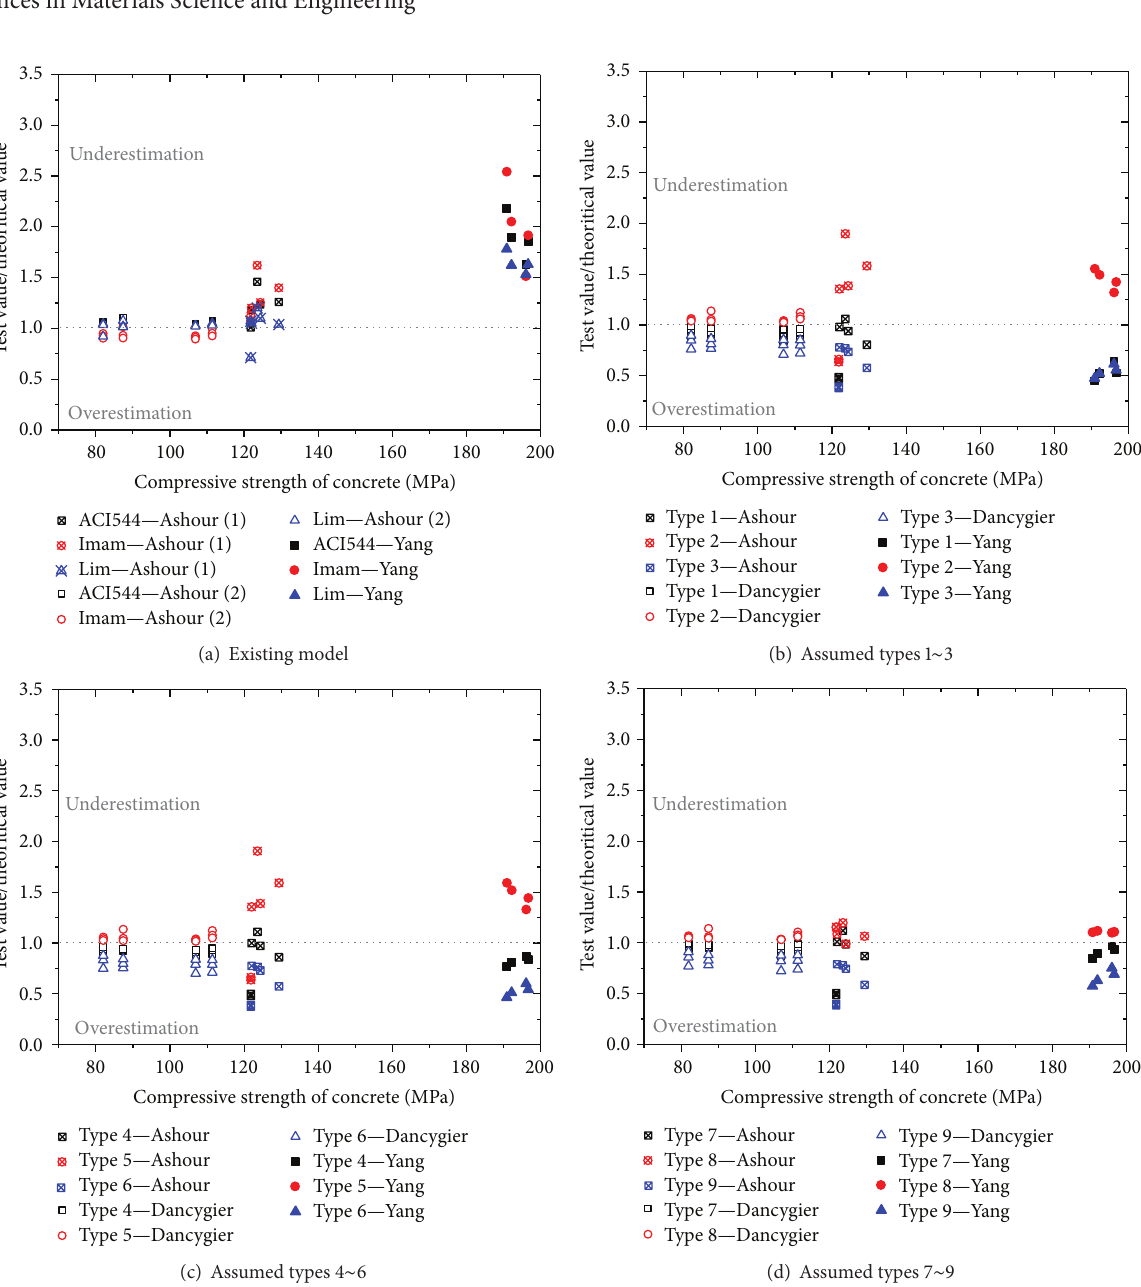
Figure 7: Applicability verification for prediction